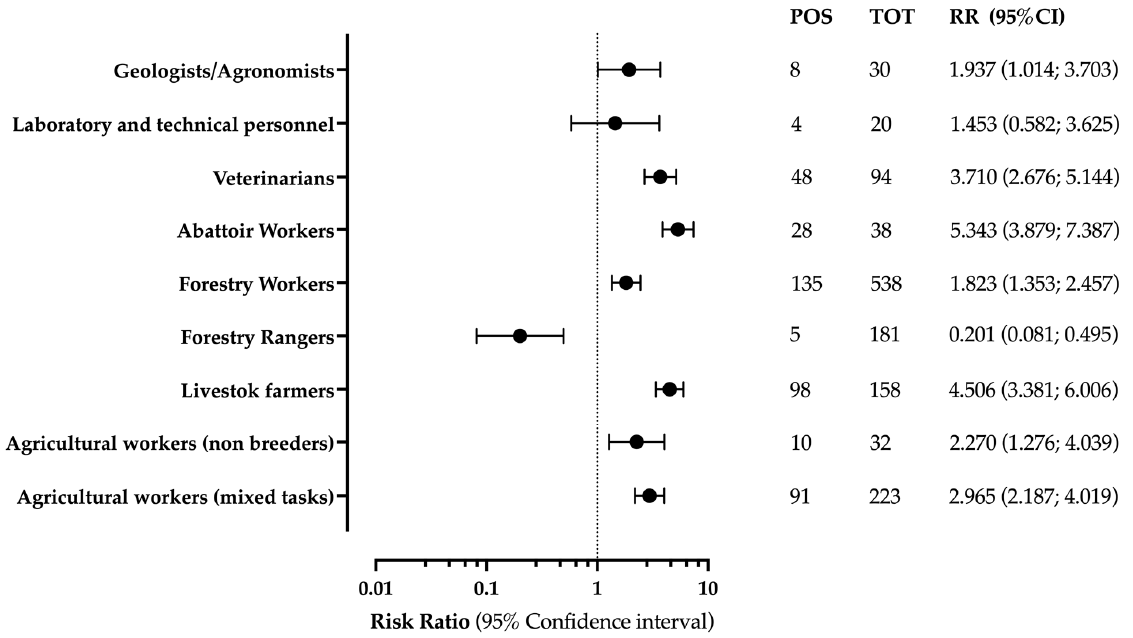
Figure 4. Forest plot representing risk ratio on main occupational groups compared to non-occupationally exposed workers (49 cases out of a total of 356 donors, 13.8%). Note: RR = Risk Ratio; 95%CI = 95% Confidence Interval.